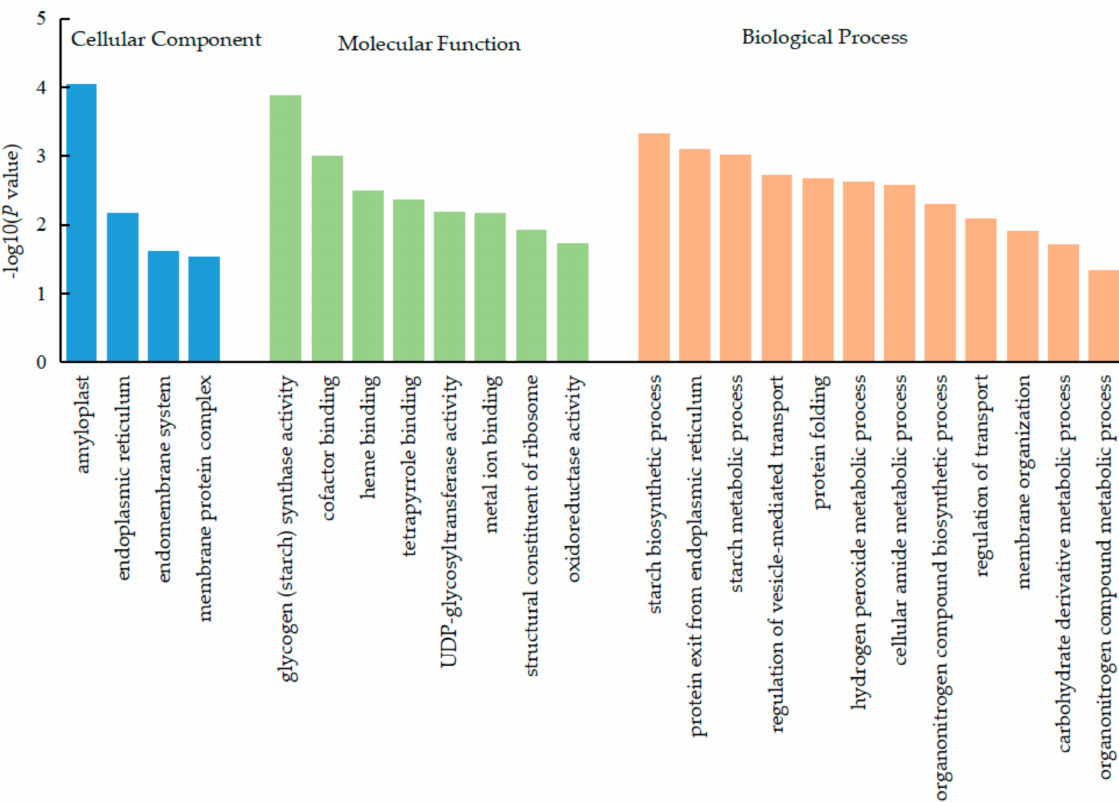
Figure 2. GO annotation statistics of the DEPs in soybean nodules tissue. The GO annotation includes cellular component, molecular function, and biological process, which are color-coded as blue, green, and orange,